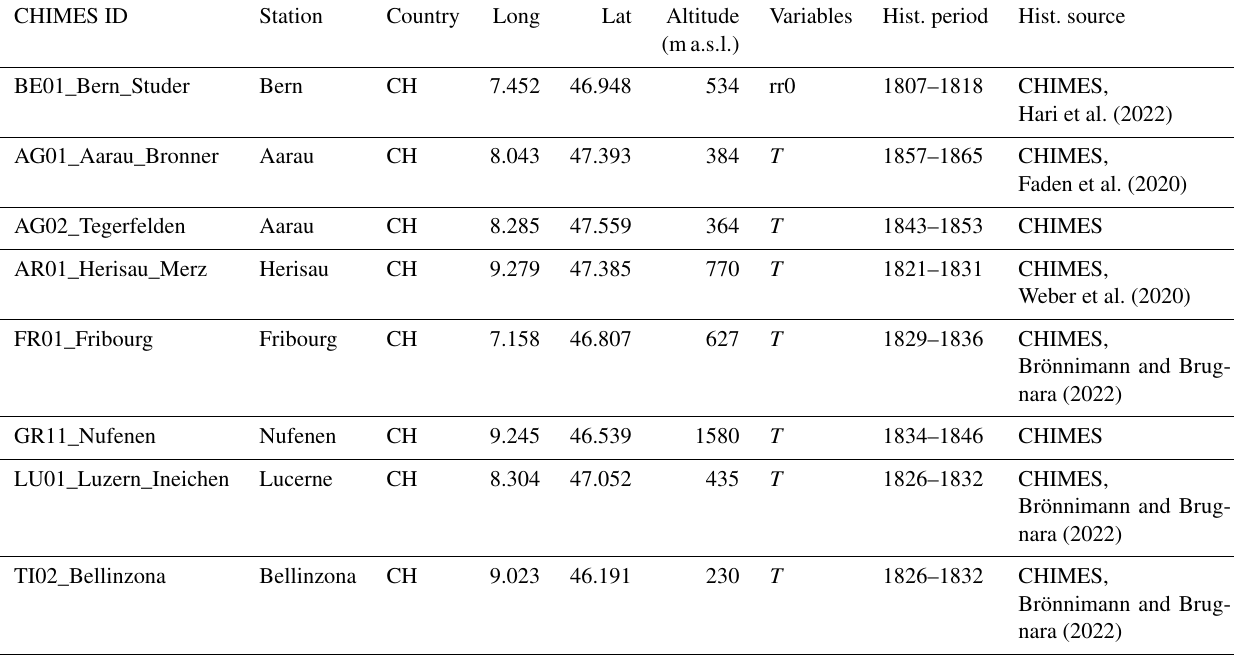
Table 2. Stations used for independent evaluation of the 1763 to 1863 period from CHIMES. A description of the CHIMES data set and where it is available is found in Brugnara et al. (2020b). If additional evaluation of the station exists, the respective reference is noted under “Hist. sources”. Station Long Lat Altitude Variables Hist. period Hist. source